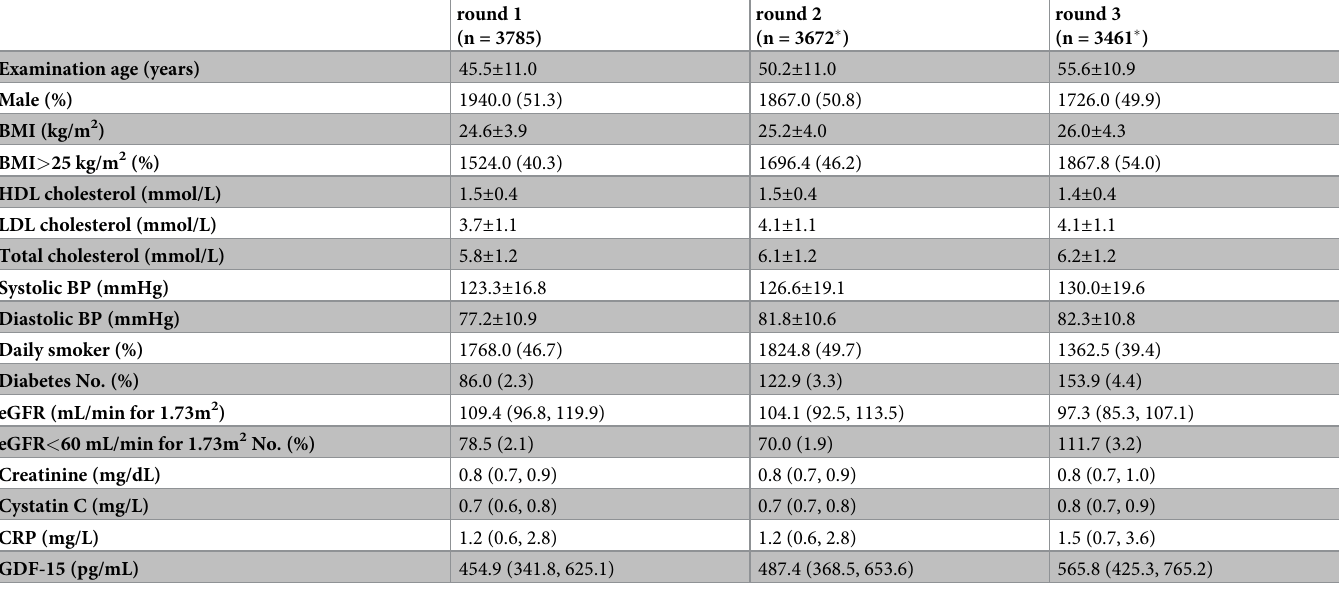
Table 1. Baseline characteristics of the DAN-MONICA cohort according to round 1–3 (Data for the imputed datasets).